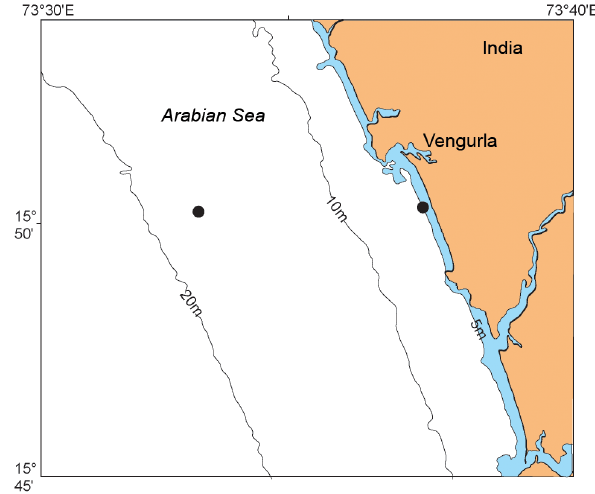
Figure 1. Location of the study area. The dark circles show the location of the waverider buoys at 15 and 5m water